Question: How would you classify this visualization?
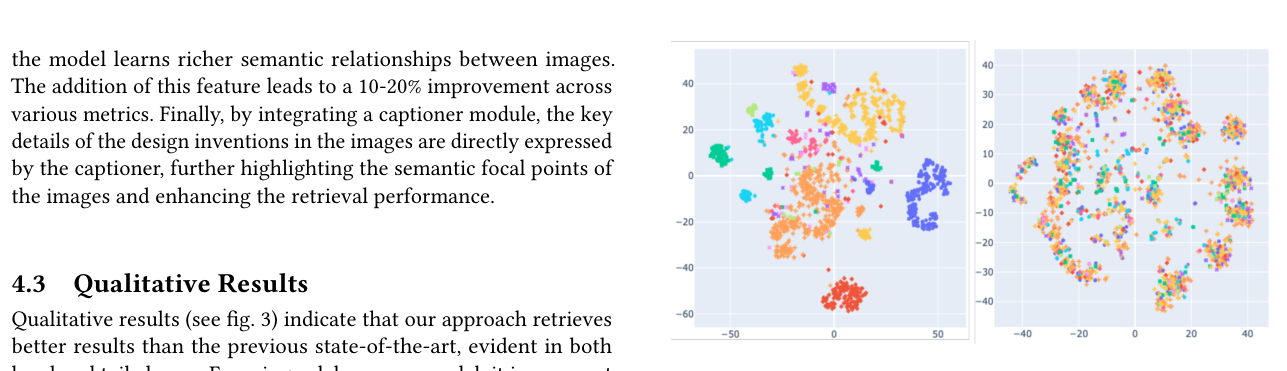
Answer: scatter